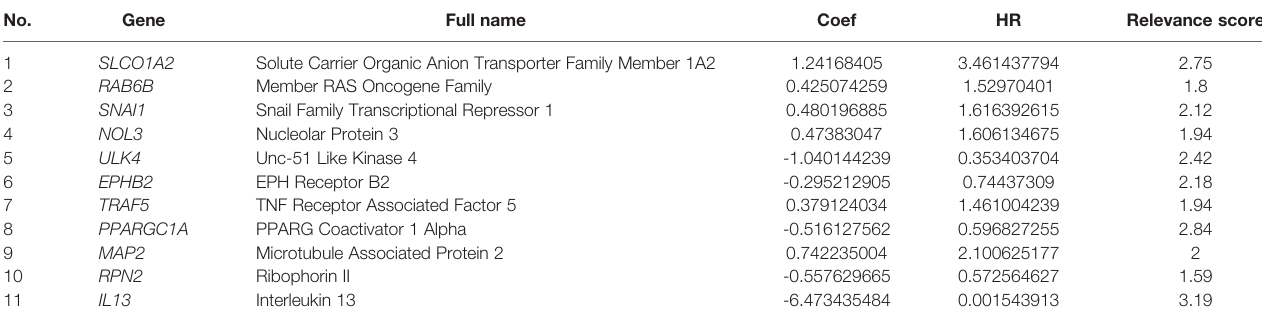
TABLE 2 | Construction of 11 autophagy-associated genes for prognosis.